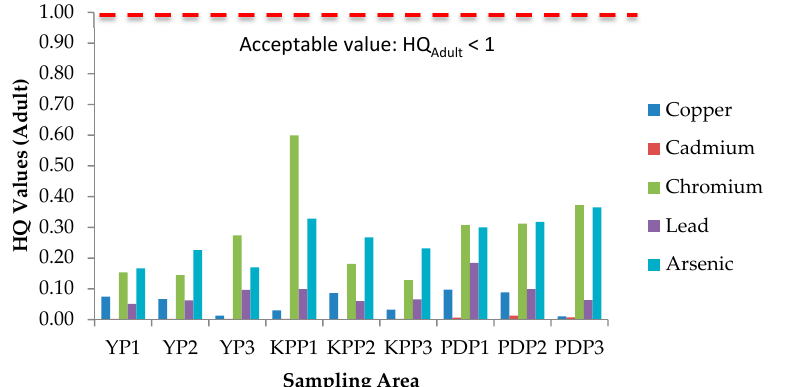
Figure 6. Hazard Quotient (HQ) values for adults in three plots of Yan, Kubang Pasu, and Pendang. YP1: Yan Plot 1, YP2: Yan Plot 2, YP3: Yan Plot 3, KPP1: Kubang Pasu Plot 1, KPP2: Kubang Pasu Plot 2, KPP3: Kubang Pasu Plot 3, PDP1: Pendang Plot 1, PDP2: Pendang Plot 2, and PDP3: Pendang Plot 3.